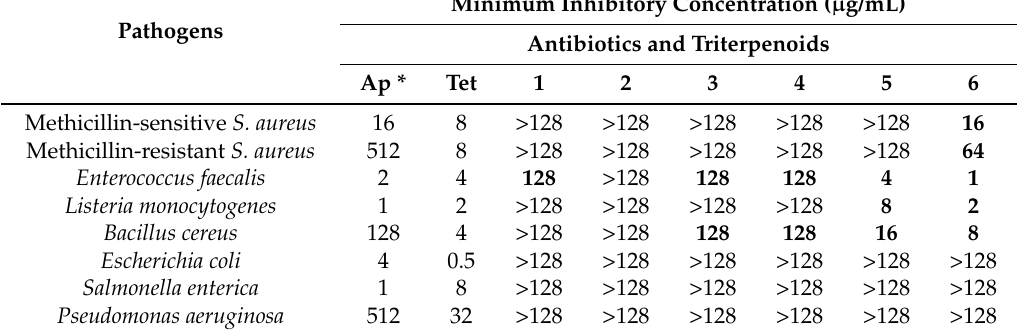
Table 2. The minimum inhibitory concentration of antibiotics and natural triterpenoids for different bacterial pathogens. Minimum Inhibitory Concentration ( µ g/mL) Pathogens Antibiotics and Triterpenoids